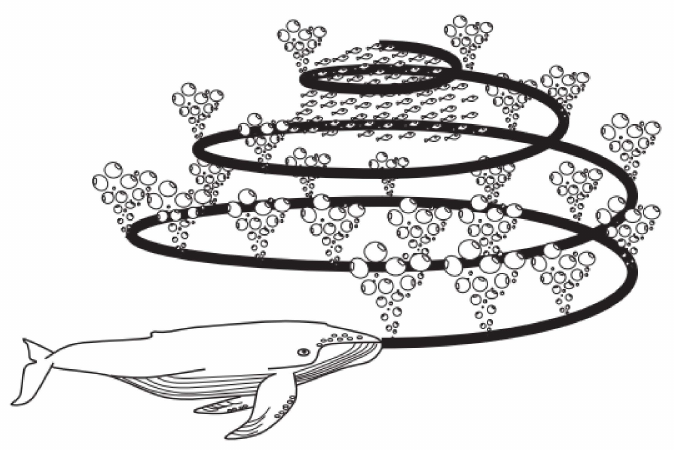
Figure 2. Humpback whale hunting